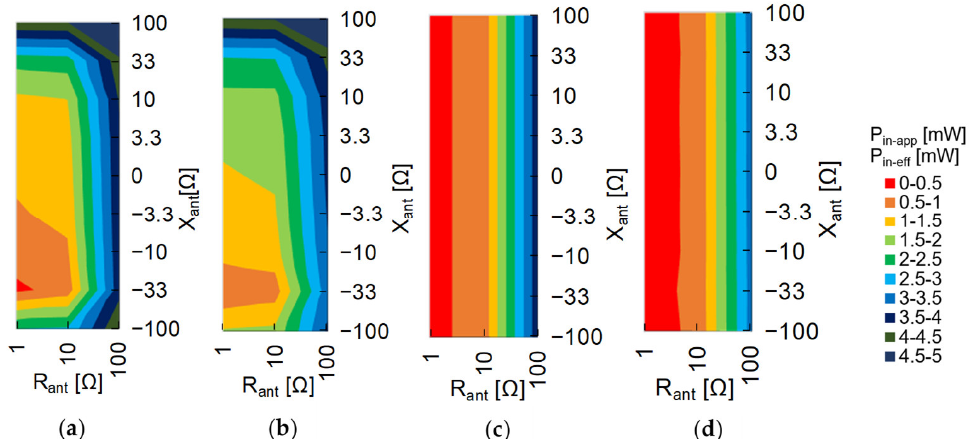
Figure 12. Contour plots of the input power in case of Model 2 with limited impedance points: ( a ) model calculation of P in − app , ( b ) SPICE simulation of P in − app , ( c ) model calculation of P in − ef f , ( d ) SPICE simulation of P in − ef f .